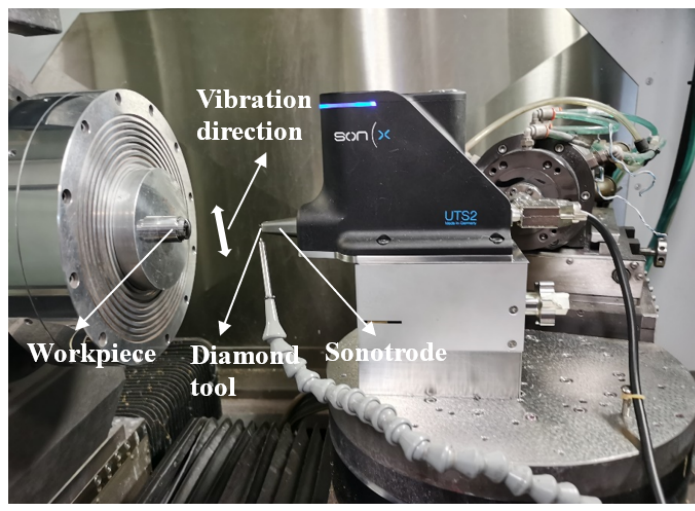
Figure 6. Photo of the machining